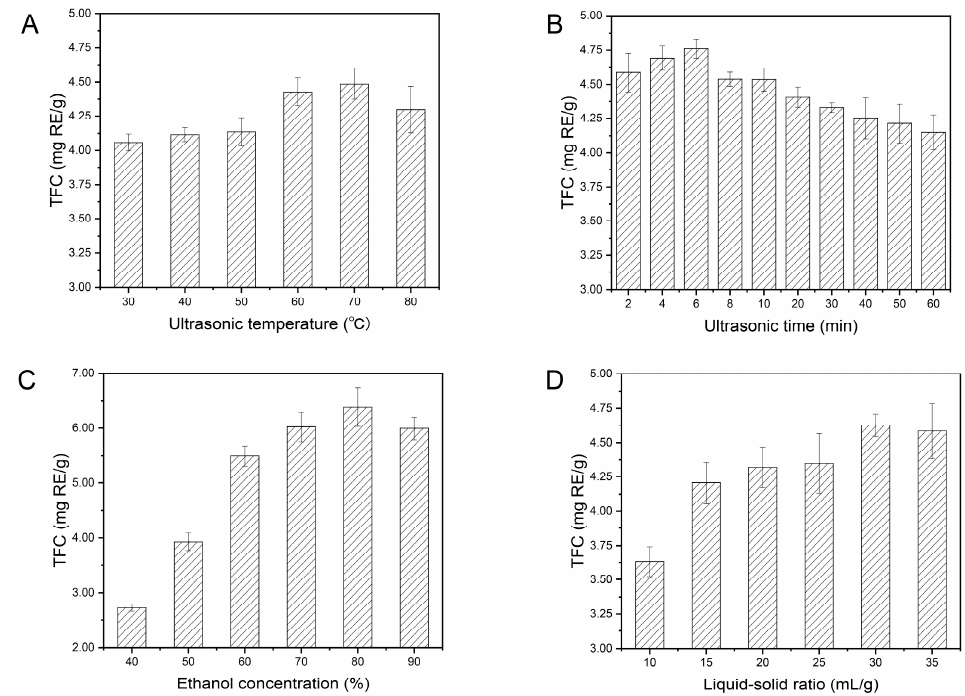
Figure 1. Effects of ultrasonic temperature ( A ), ultrasonic time ( B ), ethanol concentration ( C ) and liquid–solid ratio ( D ) on total flavonoid content (TFC). Results were expressed as average values ± standard deviation ( n = 3).